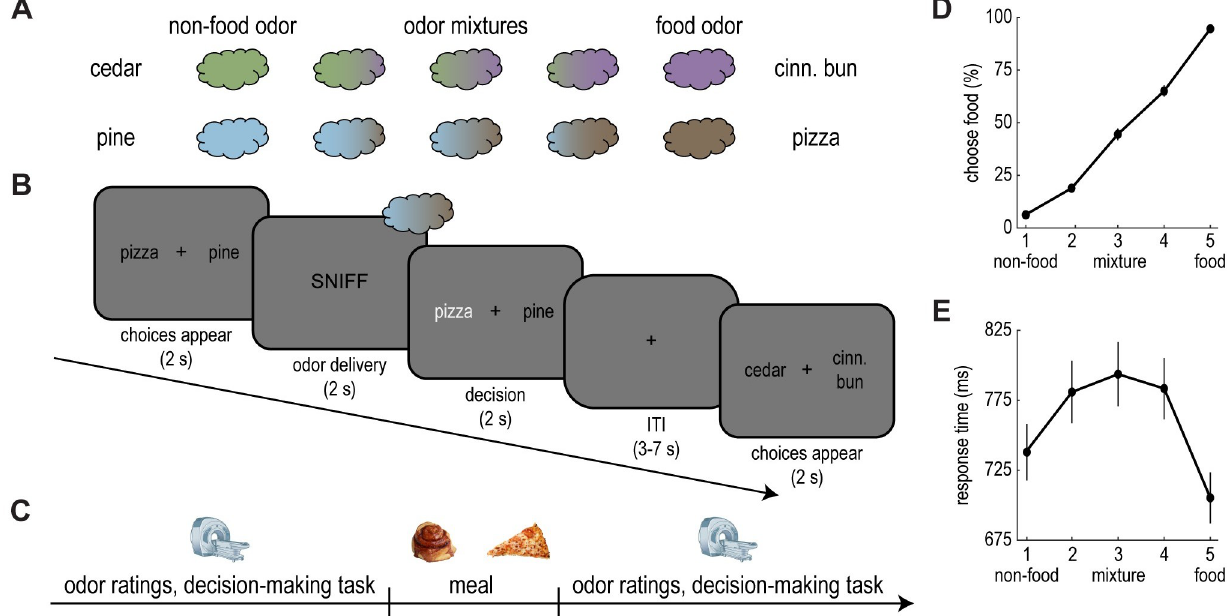
Fig 1. A novel behavioral task to probe olfactory perceptual decision-making. (A) Odor stimuli consisted of 4 pure odors (2 food and 2 nonfood) and 6 binary odor mixtures combining food and nonfood components. (B) Example trial. After choice labels appeared, participants received an odor and selected the component they perceived as dominant. Label position was counterbalanced across trials. (C) Experimental timeline. Participants completed the perceptual decision-making task during fMRI scanning, both before and after a meal. In addition, participants made appetite and odor ratings pre- and post-meal. (D) Perceptual choices. Participants were more likely to perceive odors as food dominant as the concentration of the food component increased. (E) Response times. Perceptual choices were slower for the odor mixtures. Error bars depict SEM for n = 30. Individual participant data summarized in these plots can be found in S1 Data . fMRI, functional magnetic resonance imaging; ITI, intertrial interval; SEM, standard error of the mean.